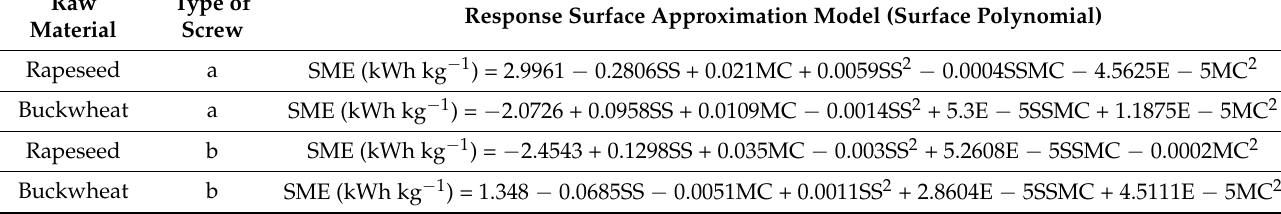
Table 2. Models of response surface approximation for the energy consumption of extrusion-cooking of rapeseed and buckwheat straws depending on the process